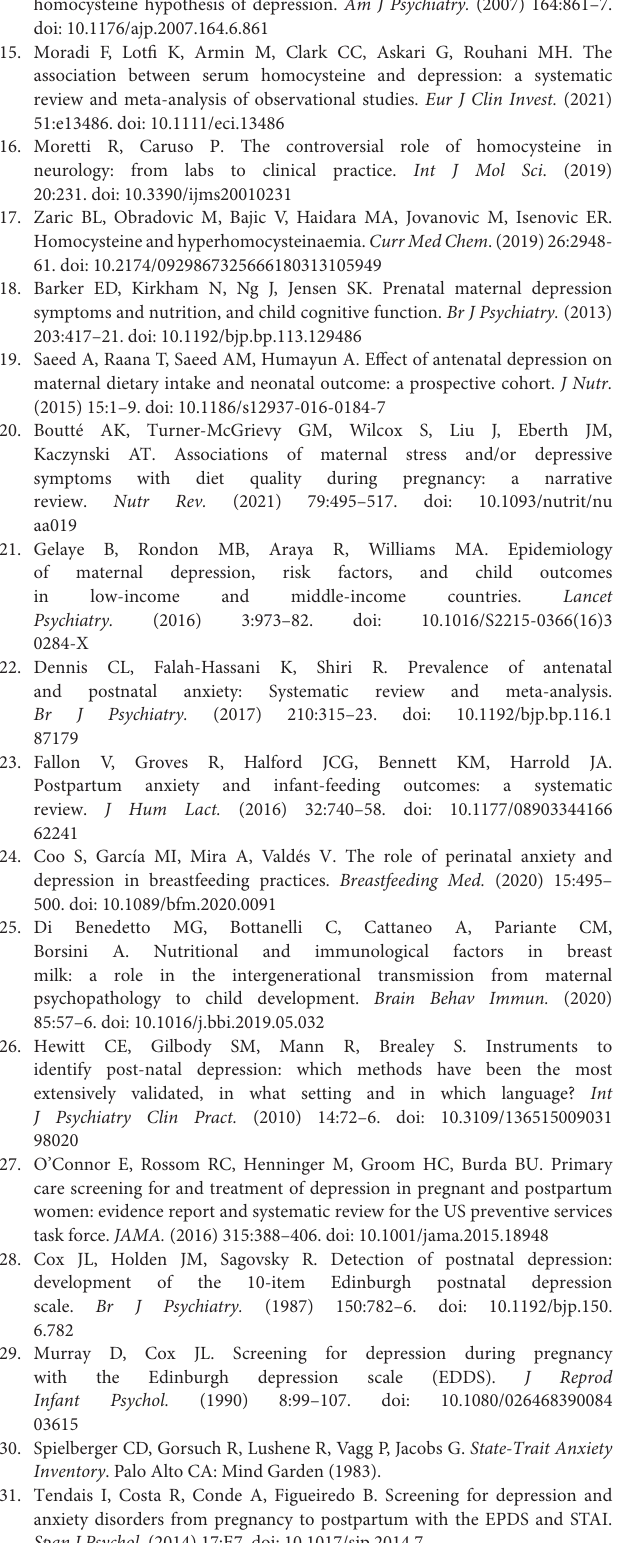
homocysteine with major depressive disorder: results from a large population-based